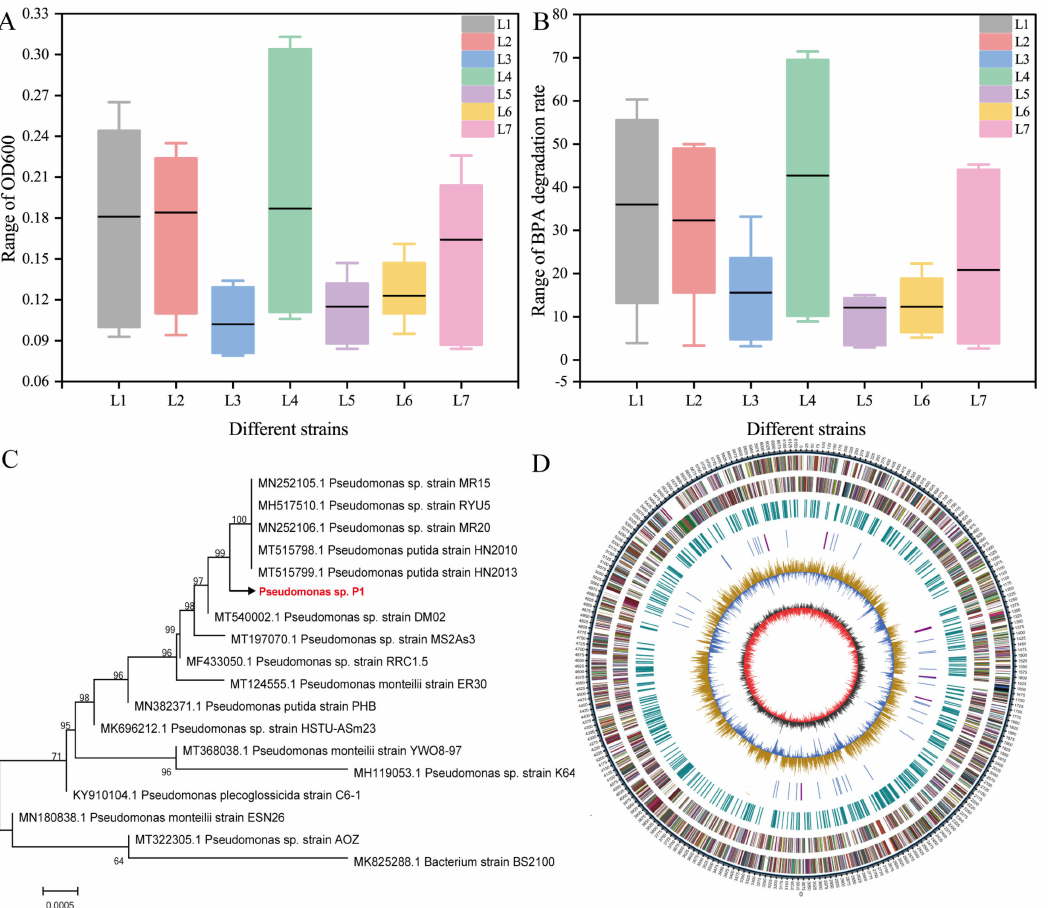
Figure 1. Screening and identification of bisphenol A-(BPA)-degrading bacteria. For seven bacterial strains (L1–L7): ( A ) Bacterial growth in MSM medium containing 100 mg/L BPA, and ( B ) BPA degradation rates; different strains are expressed in different colors in the figure and corresponding to the abscissa. ( C ) 16S rDNA sequence alignment used for morphological identification of bacterial strains; and ( D ) results of genome sequencing showing that the genome of strain Pseudomonas sp. P1 was composed of a singular circular chromosome. Different colors represent the distribution of different functional